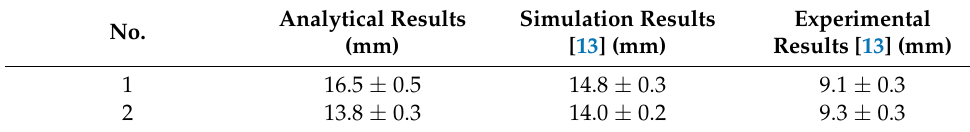
Table 6. Comparison of results for the focal plane position L CD .